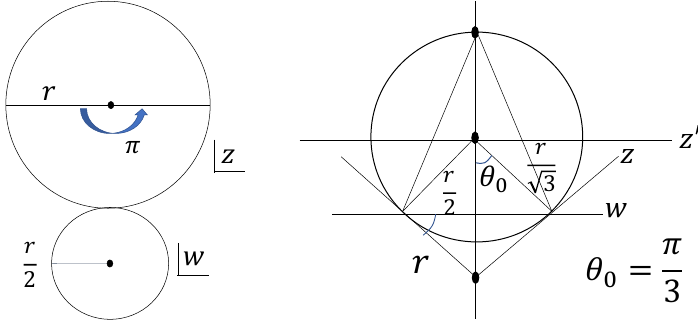
Figure 1 . The left panel shows the net of a cone cut out from T 2 = Z 2 with the coordinates of T 2 = Z 2 z and the cut edge w , whereas in the right panel, the cone cut out by T 2 = Z 2 whose coordinate is z p 3 whose coordinate is z 0 or w are and a section of embedded quarter of S 2 with radius r=